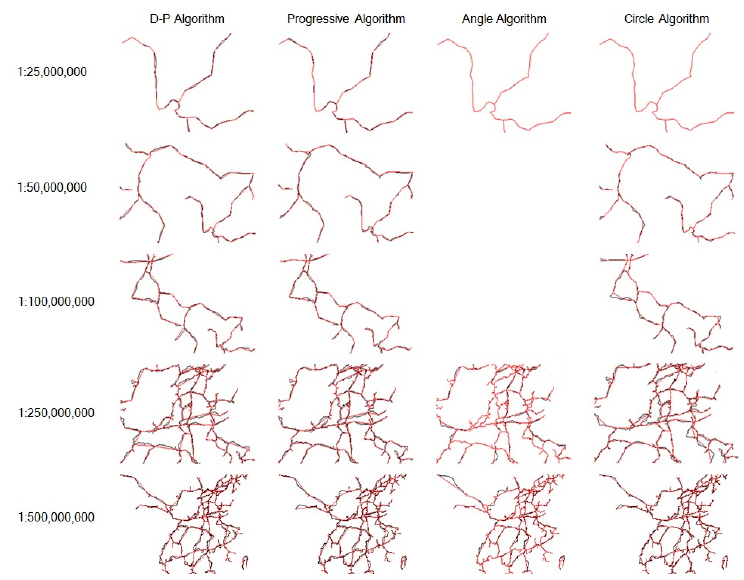
Figure 6. The simplification results of four algorithms.